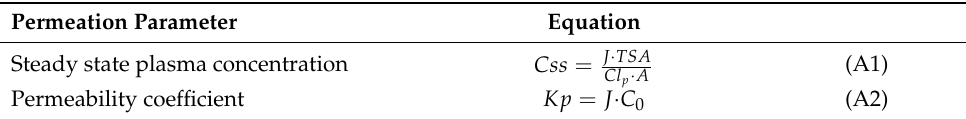
Table A3. Permeation Parameters and Calculation of the Css upon Application of alginate-HA gel 2% KT.